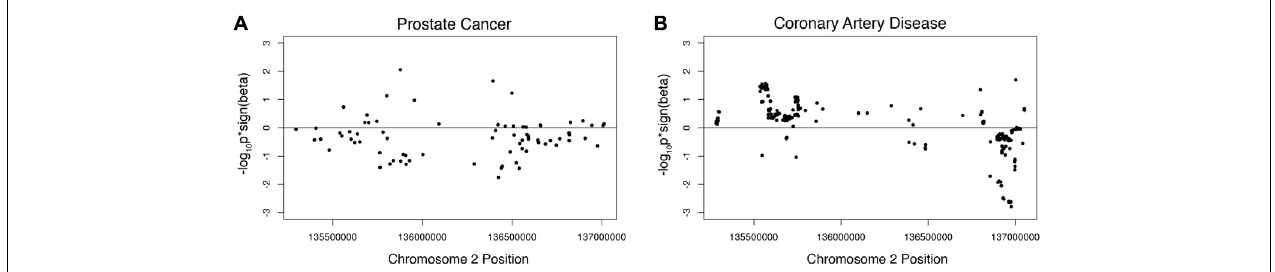
FIGURE 2 | Wilcoxon rank sum tests showing beta signed p -values for (A) prostate cancer associated SNPs in high LD with the lactase persistence SNP and (B) CAD associated SNPs in high LD with the lactase persistence SNP.